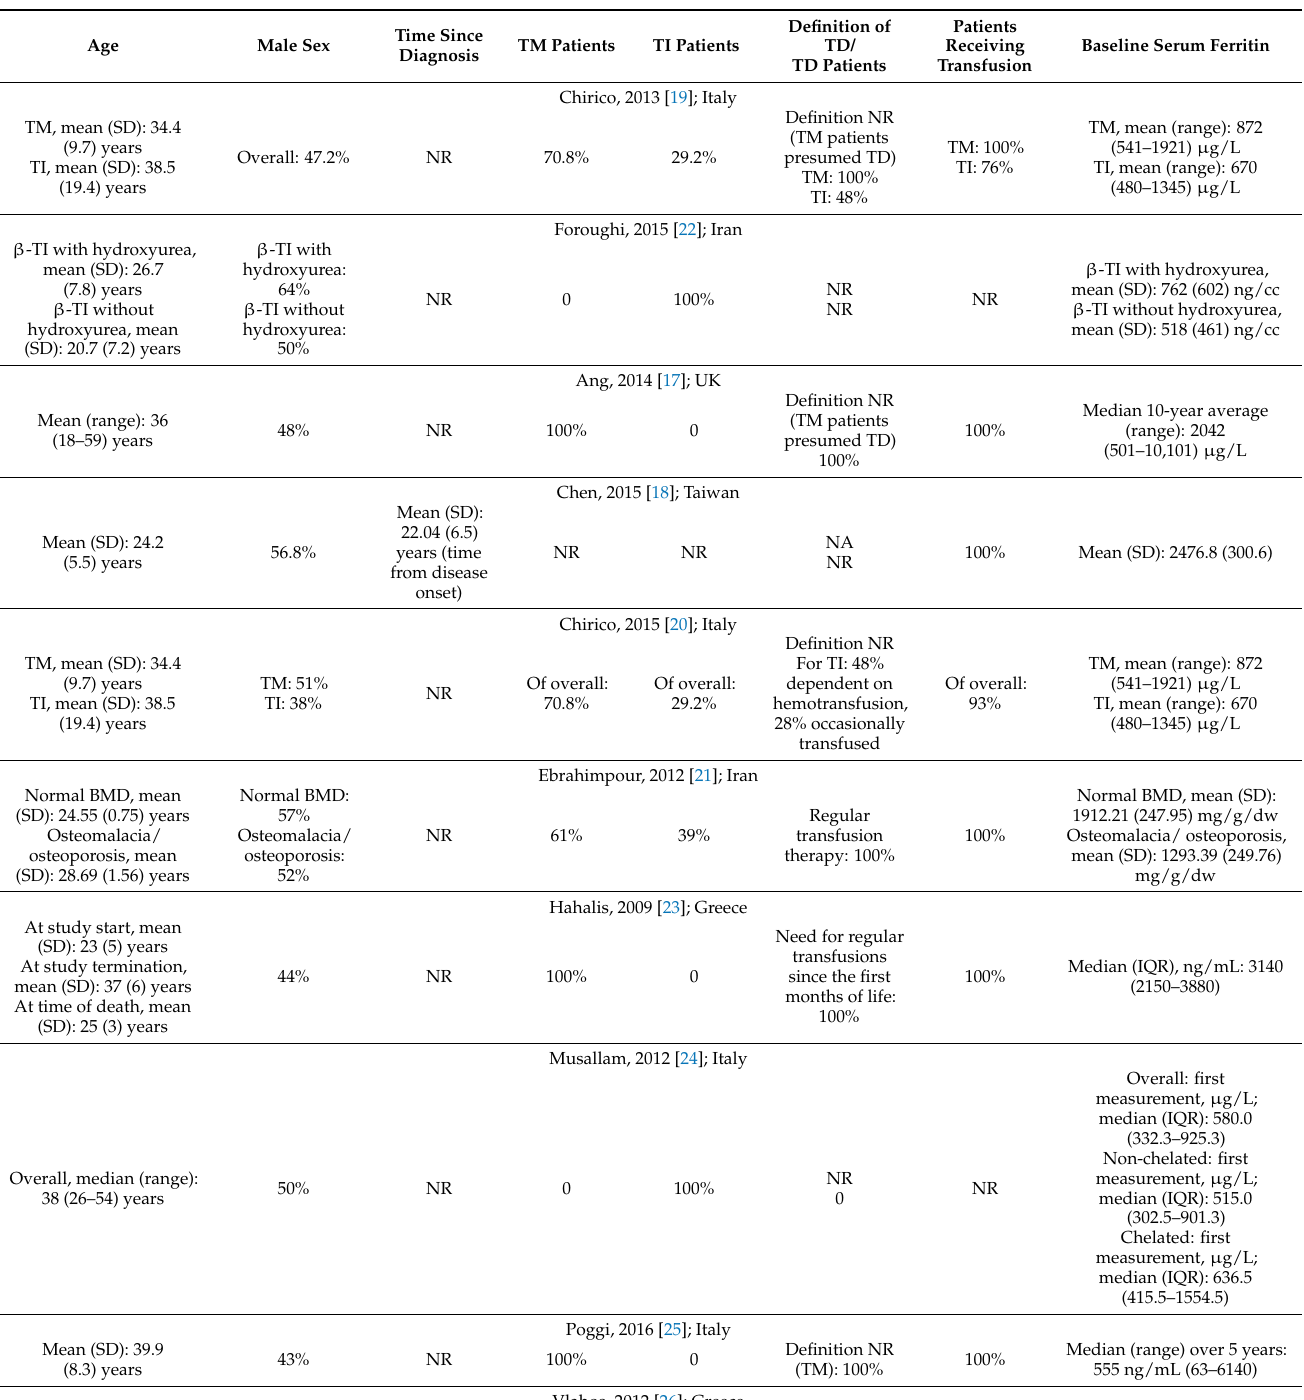
Table 2. Patient characteristics of β -thalassemia